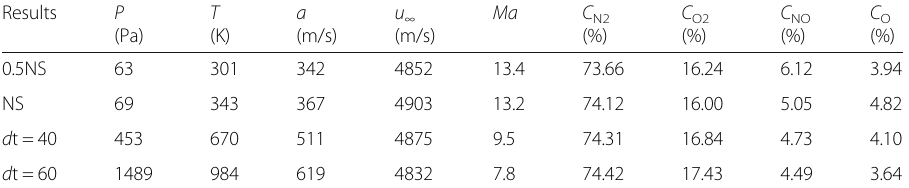
Table 8 Comparison of flow parameters in the centerline at nozzle outlet based on the FD-21